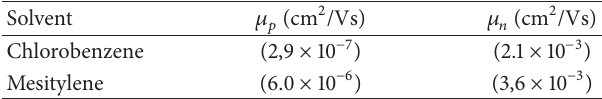
Table 2: Mobility values of majority and minority carriers in P3HT films prepared from chlorobenzene and mesitylene based